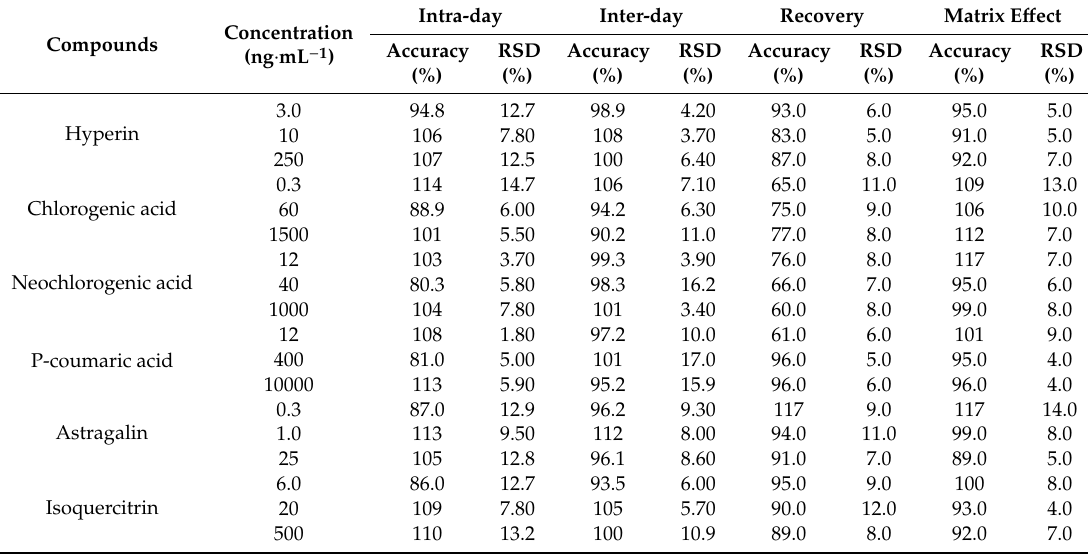
Table 3. Intra-day and inter-day values, recovery, matrix e ff ect accuracy, and precision of six compounds ( n =